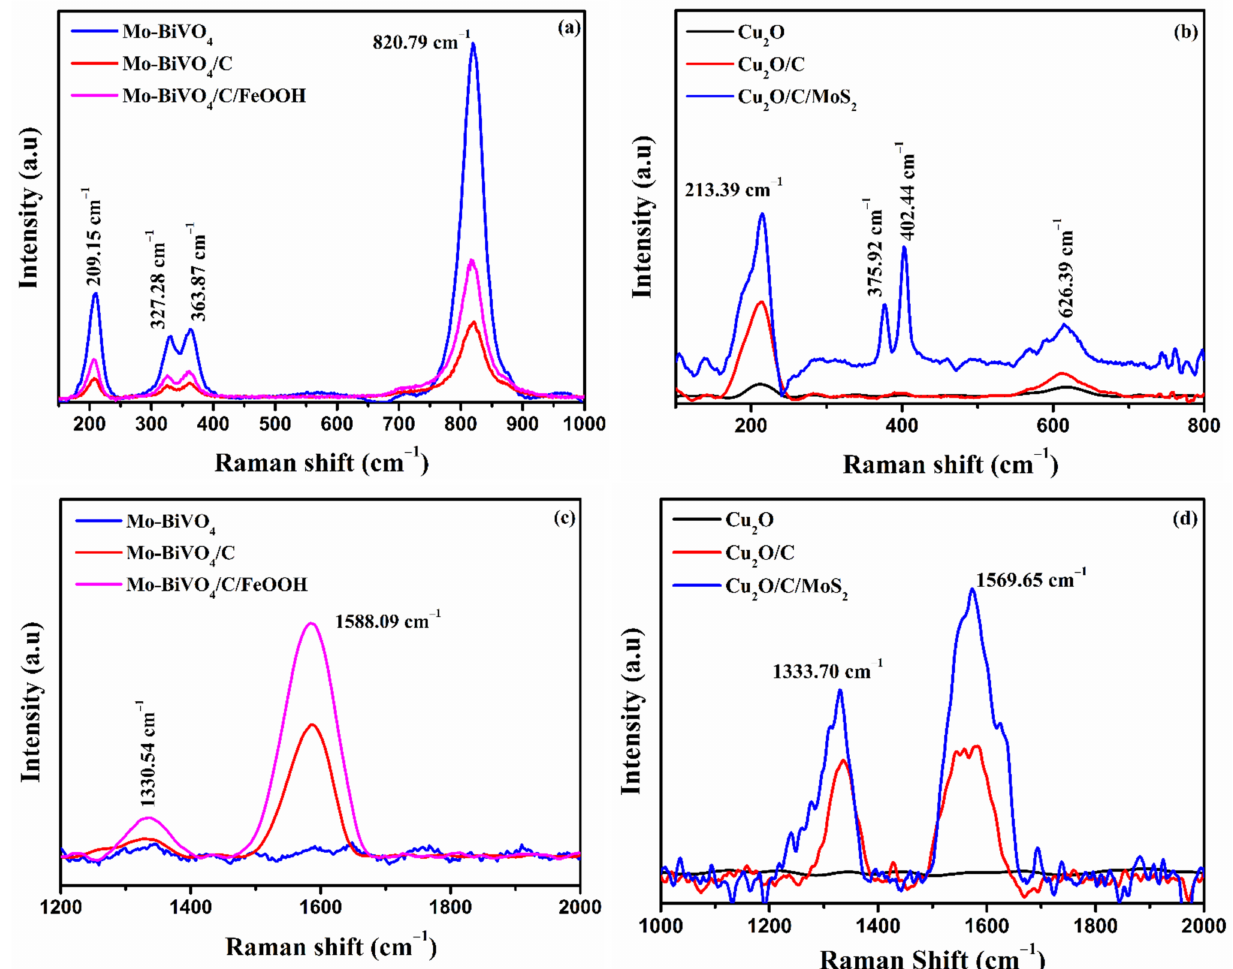
Figure 1. Raman Spectra of ( a ) Mo-BiVO 4 , Mo-BiVO 4 /C , and Mo-BiVO 4 /C/FeOOH photoanodes, ( b ) Cu 2 O, Cu 2 O/C, and Cu 2 O/C/MoS 2 photocathodes. Presence of a carbon layer in ( c ) BiVO 4 photoanodes and ( d ) Cu 2 O